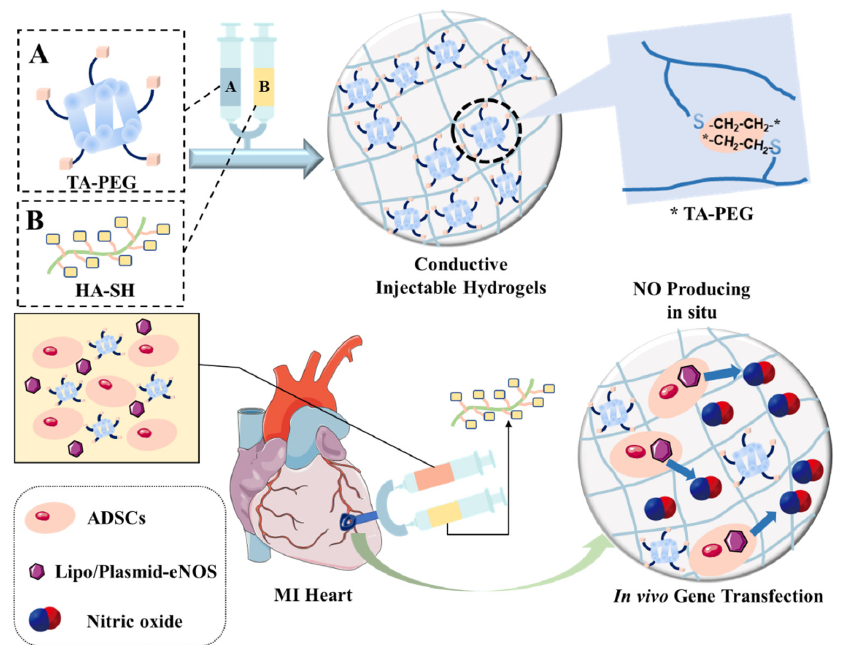
Figure 10. Schematic diagram of the conductive injectable hydrogel, which is employed to load plasmid DNA-eNOs nanoparticles and ADSCs to treat myocardial infarction. “A” represents TA-PEG, and “B” represents HA-SH. Reproduced with permission from [153], Biomaterials, 2018.